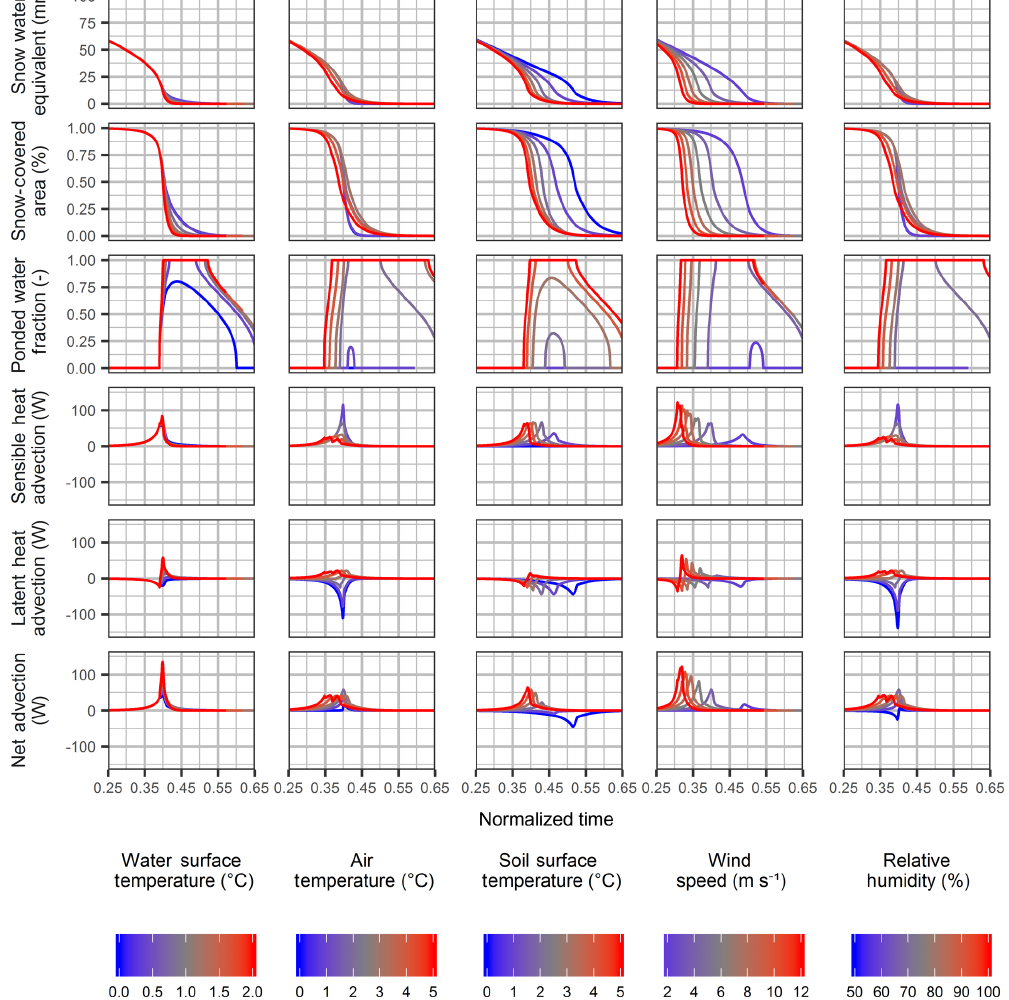
Figure 10. Sensitivity of snow water equivalent and snow-covered area depletion, ponded water fraction, sensible heat advection, latent heat advection and net advection with respect to variation in water surface